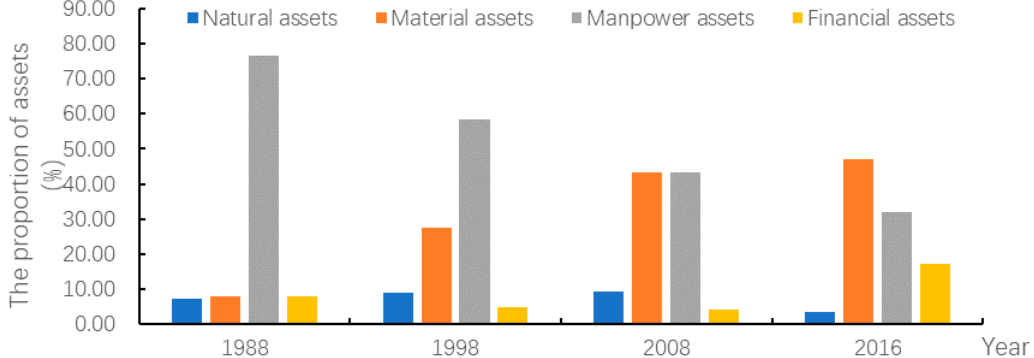
Figure 3. The livelihood asset structure in 1988, 1998, 2008, and 2016.